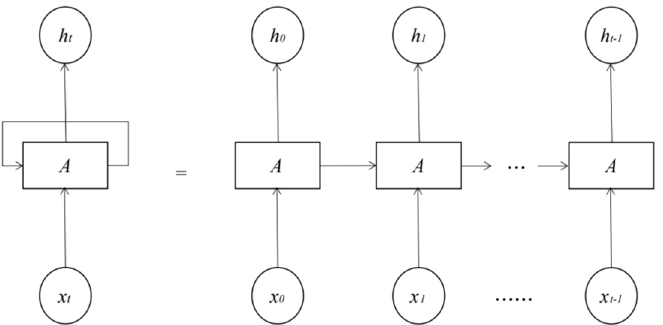
Figure 2. The schematic diagram of neurons and unfolding time series of cyclic neural network.